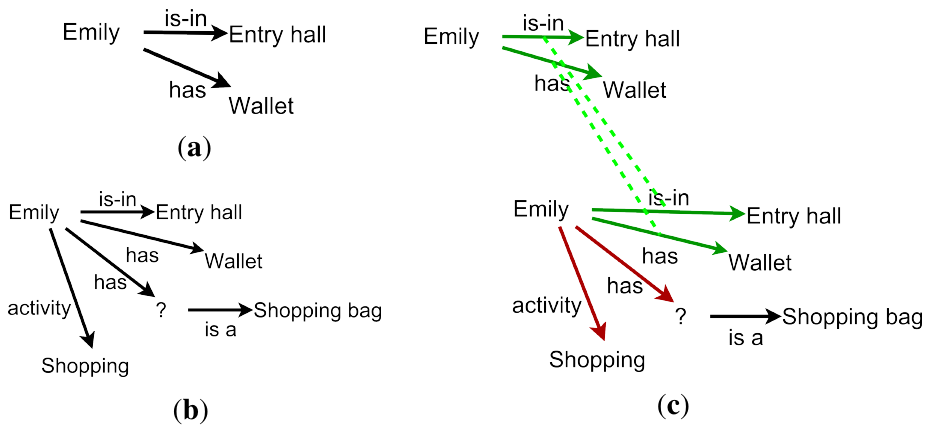
Figure 3. ( a ) A context graph saying Emily is in the hall and has the keys. ( b ) A context pattern describing the situation in which Emily goes shopping, taking her wallet and shopping bag. ( c ) A match between the context graph and context pattern, showing what matches and what is